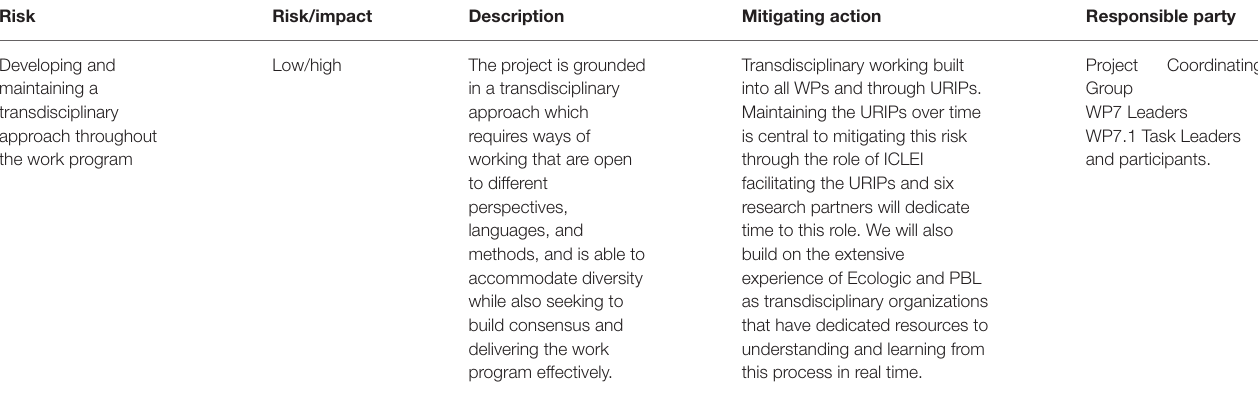
TABLE 1 | Risks of the transdisciplinary approach in Nature-Based Urban Innovation (NATURVATION) and mitigating actions (adapted from Bulkeley,